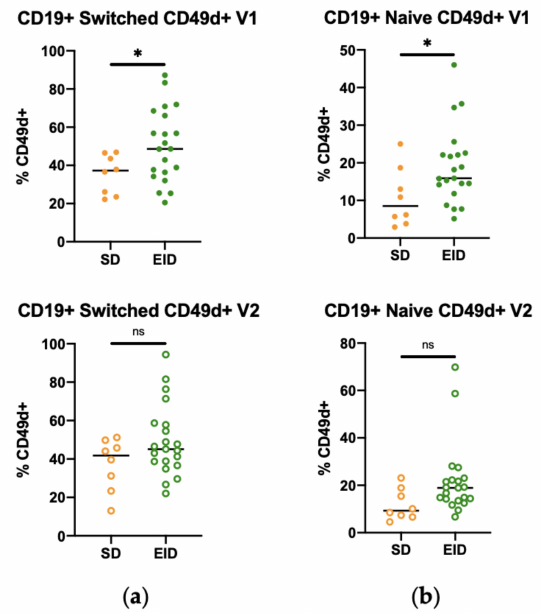
Figure A5. Representation of SD and EID groups in some CD19 + B lymphocytes subpopulations in RRMS patients under Natalizumab treatment in both first (V1) and second (V2) extractions. Percentage of expression of CD49d in ( a ) CD19 + Switched and ( b ) CD19 + Naïve B lymphocytes. Each dot represents the percentage of expression for each marker regarding their parent population (CD19 + B lymphocytes populations) in the SD ( n = 8) or EID ( n = 21) groups. EID, extended interval dosing; SD, standard dosing. ns: p > 0.05, * p < 0.05.